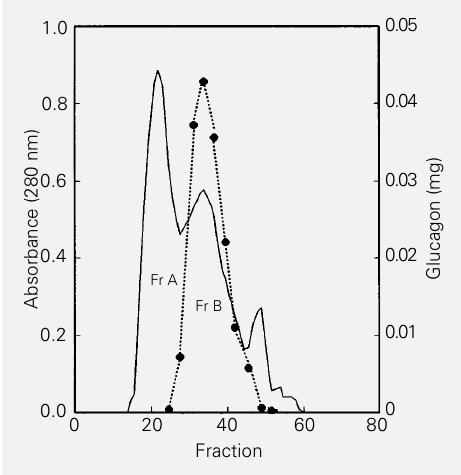
Figure 2 - Gel filtration chromatography of glucagon on Sephadex G-25. The sample, 70 ml of fraction A (Fr A) from Q-Sepharose FF (Figure 1), was applied to a 3.0 x 100-cm column and eluted at room tem- perature with 0.1 M acetic acid at a flow rate of 7.0 ml/min. Fractions of 10 ml were collected and the amount of glucagon was determined by HPLC as shown in Figure 4. Absorbance at 280 nm (solid line), mg glucagon (dashed line).